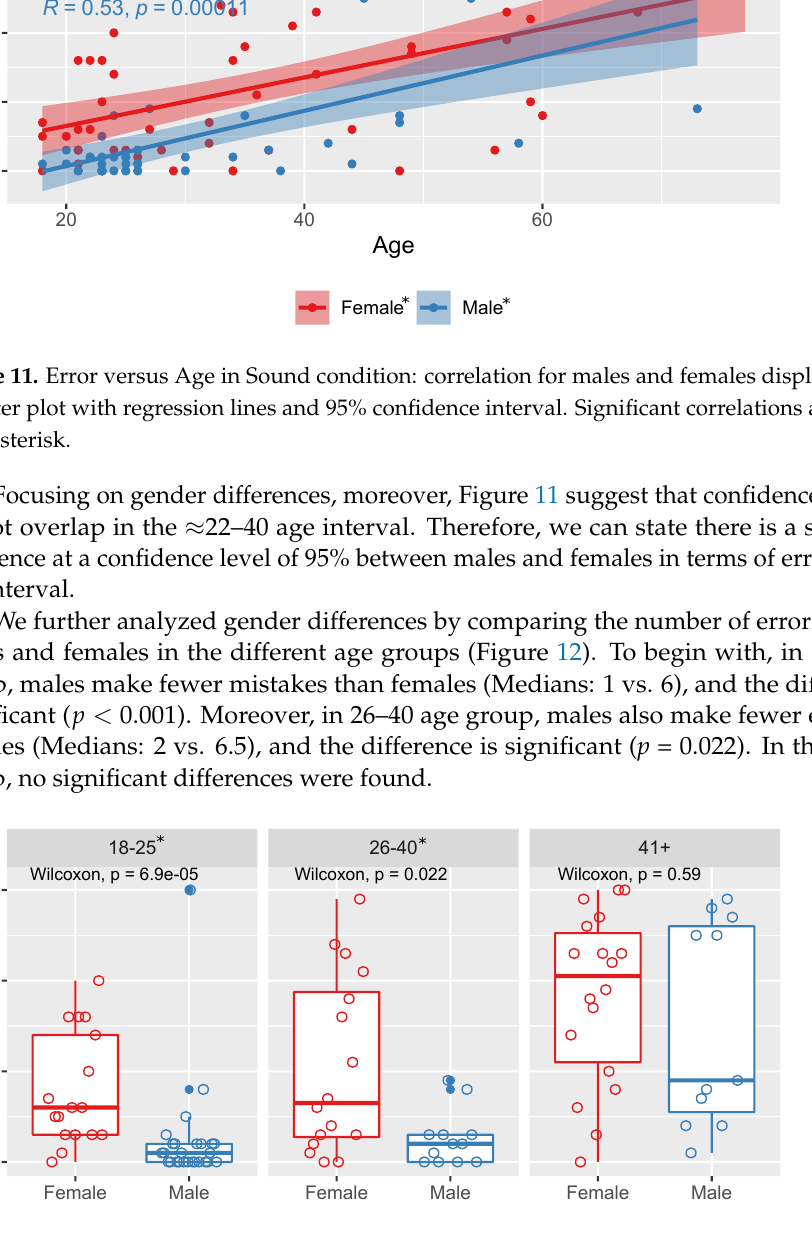
Figure 12. Boxplots comparing age groups of males and females regarding errors in “Mute” condition. Significant differences are marked with